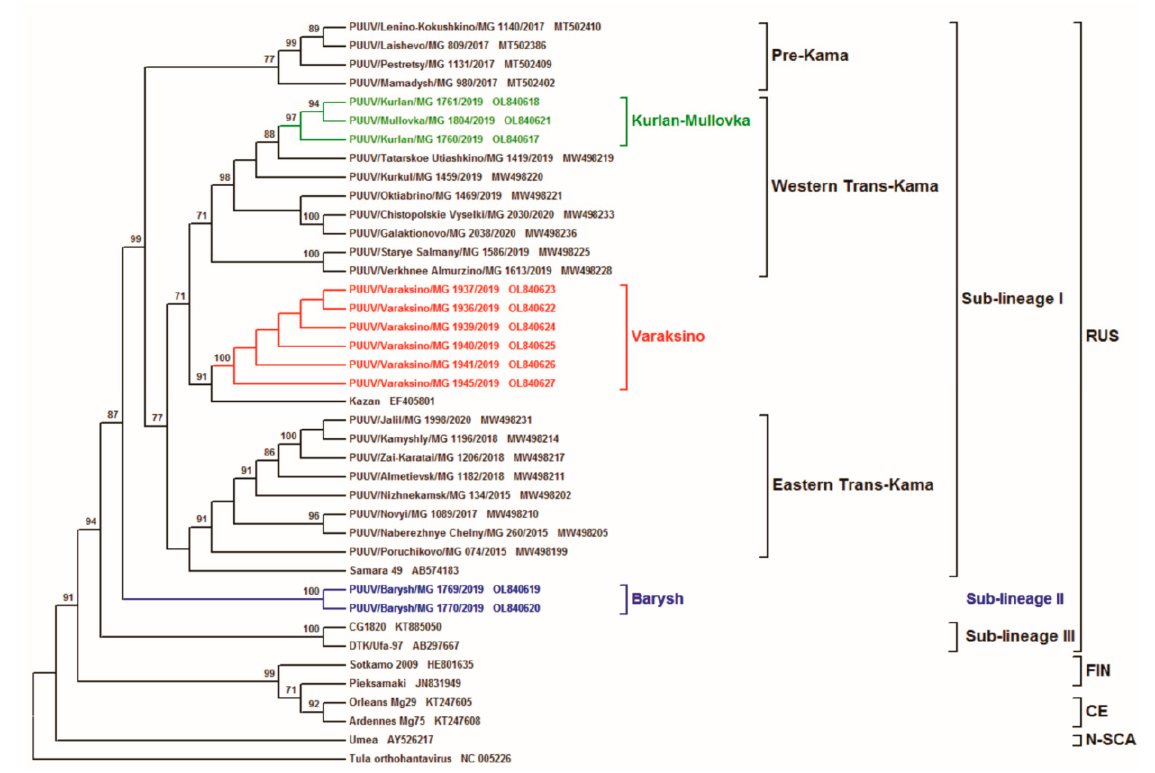
Figure 4. Phylogenetic tree calculated based on the partial (603 bp) of PUUV L segment sequences obtained from bank voles trapped in ULR and UR areas. The sequence position was aligned against GenBank PUUV Kazan strain, accession number EF405801.